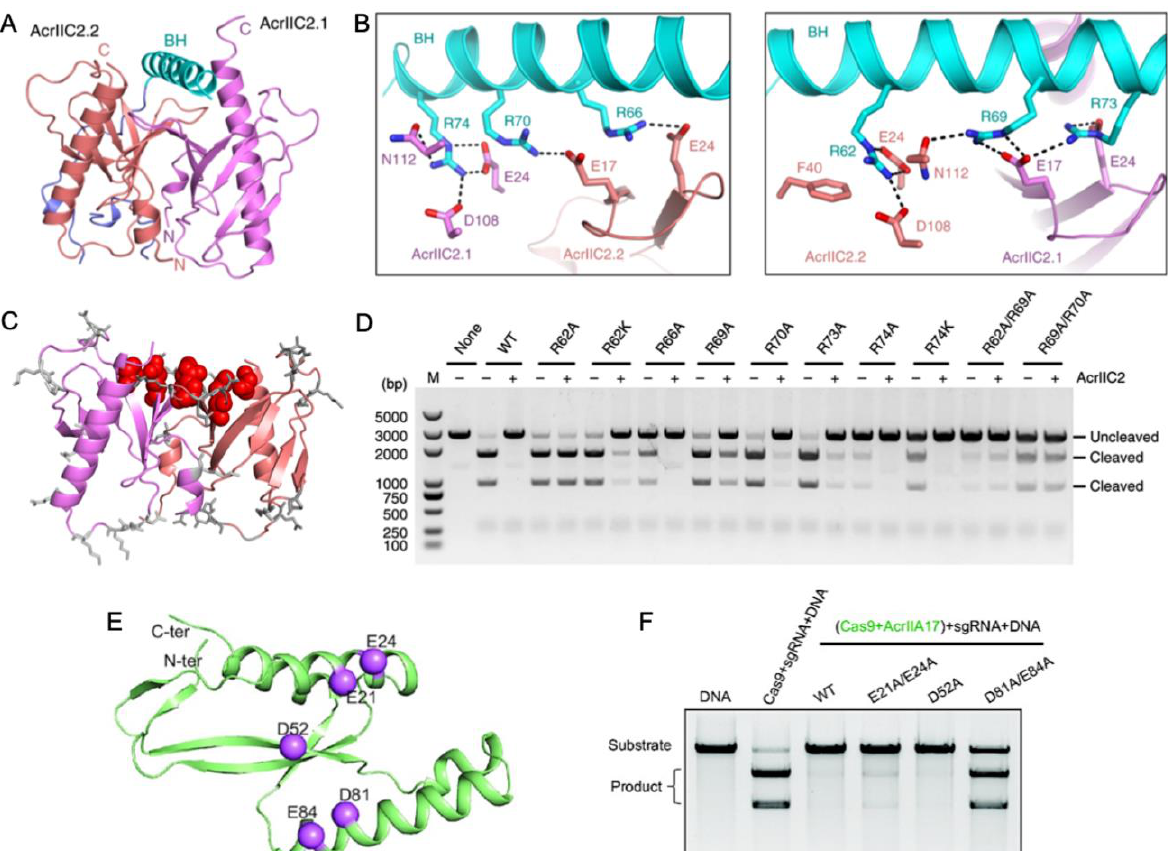
Figure 4. Acr interactions with the nucleic acid bridge helix ( A ) Crystal structure of AcrIIC2 depicts a homodimer (red and purple subunits) that interacts with the Nme Cas9 bridge helix (cyan). ( B ) Hydrogen bond and salt bridge interactions between the Nme Cas9 bridge helix (cyan) and identical subunits of AcrIIC2 (red and purple). ( C ) Summary of surface-exposed residues hypothesized to have functional impact on the AcrIIC2- Nme Cas9 interaction. Sites with no functional impact when mutated are depicted as gray sticks, while those that strongly affect the ability of AcrIIC2 to inhibit Nme Cas9 are shown in red. ( D ) DNA cleavage assay conducted in the presence of Nme Cas9 and wild-type AcrIIC2, as well as AcrIIC2 variants outlined in ( C ). Mutations along the bridge helix-interacting region of AcrIIC2 arrest its inhibitory function. ( E ) Predicted AlphaFold structure of AcrIIA17 showing hypothesized sites of functional importance based on charge complementarity to the Cas9 surface (purple spheres). ( F ) Alanine mutations at the highlighted sites in ( B ) attenuate the affinity of AcrIIA17 for Cas9 and modulate its ability to inhibit Cas9 DNA cleavage. Figure 4A – D is reprinted/adapted from Thavalingam, A. et al. Inhibition of CRISPR-Cas9 ribonucleoprotein complex assembly by anti-CRISPR AcrIIC2 [33]. Figure 4E,F is reprinted/adapted from Wang, X. et al. Inhibition mechanisms of CRISPR-Cas9 by AcrIIA17 and AcrIIA18 [53].